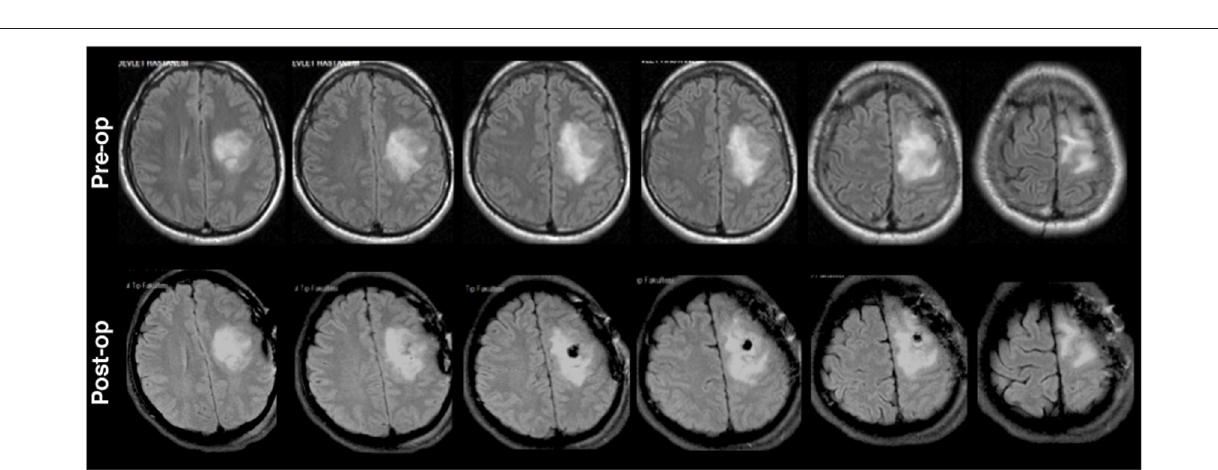
Frontiers in Neuroscience |